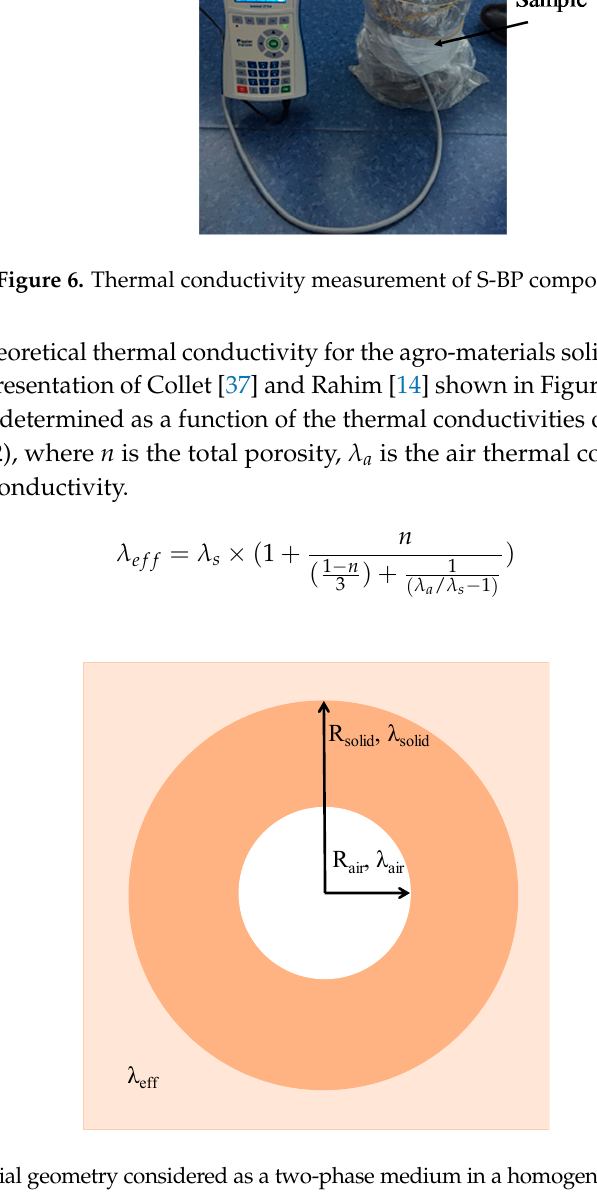
Figure 7. Agro ‐ material geometry considered as a two ‐ phase medium in a homogeneous equivalent medium.